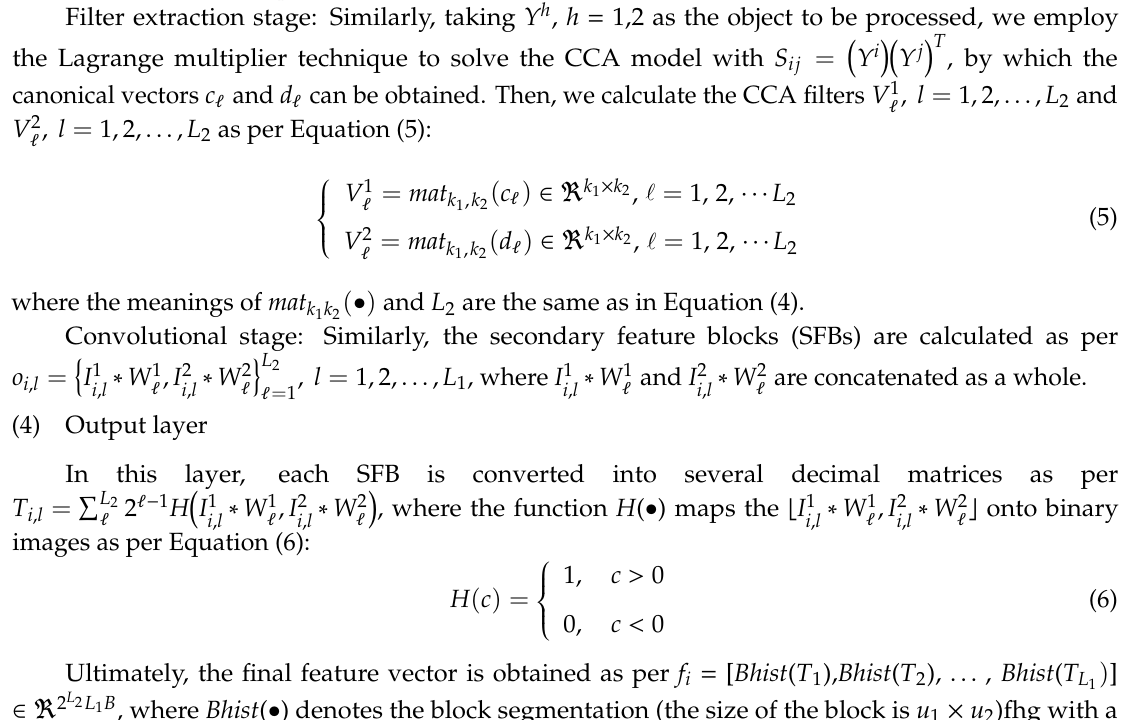
Algorithm 1. The algorithm of two convolutional stages of the DL-CCANet.